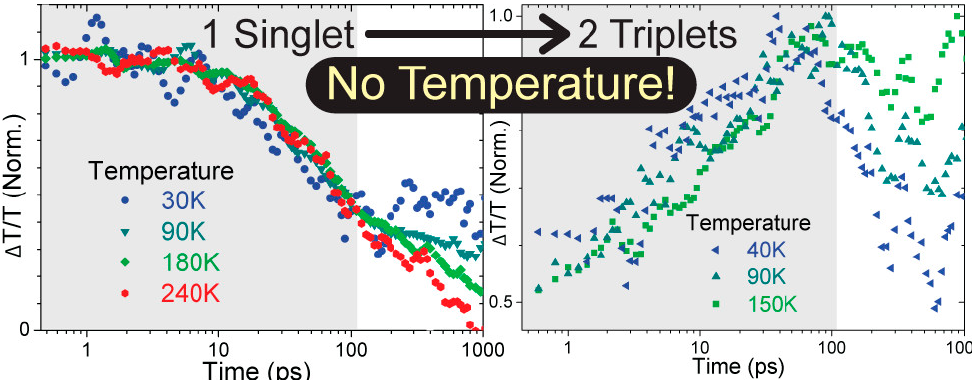
Figure 2. The temperature-dependent dynamics of the TA signal for singlet and triplet excitons in a tetracene film. Reprinted with permission from Ref. [32]. Copyright 2013, American Chemical Society.